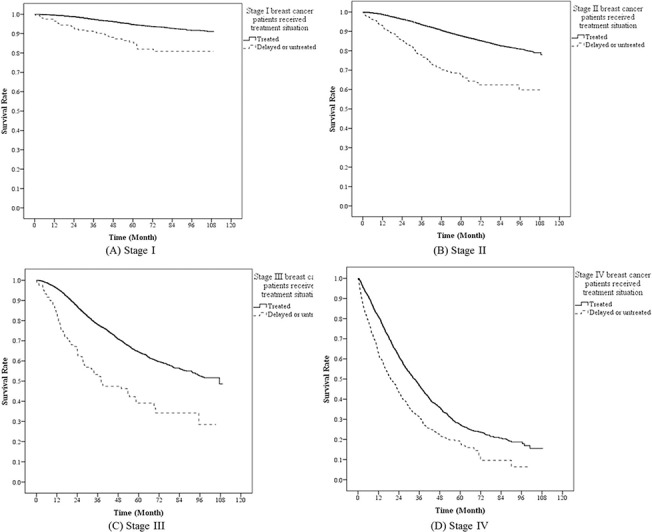
Survival curves between treated and delayed/untreated patients of breast cancer at different stages.